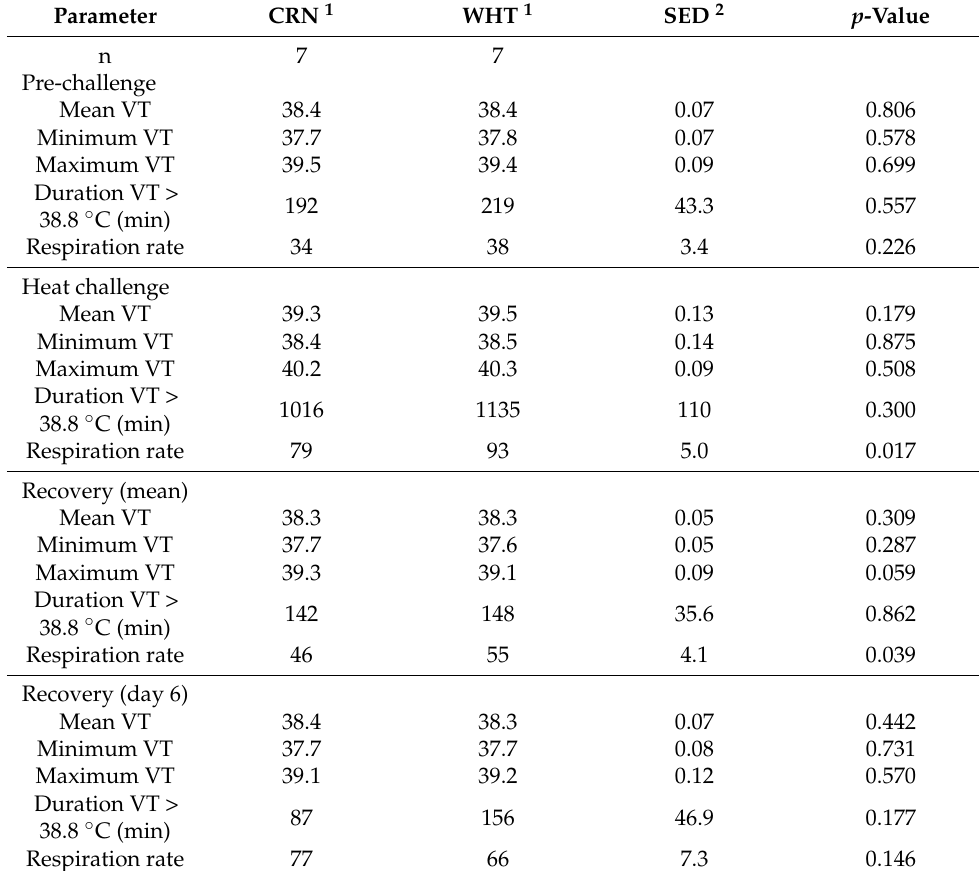
Table 4. Vaginal temperature (VT, ◦ C), and respiration rate (breaths per minute) during each period of the experiment, and on day 6 of the recovery